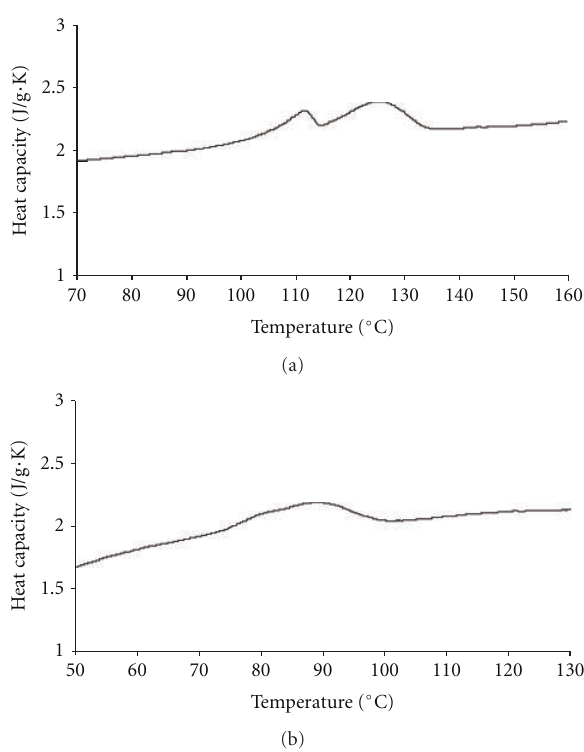
Figure 17: DSC thermograms for cholesteryl benzoate dispersed in UV15 at scanning rate of 10K · min − 1 , (a) heating, (b)